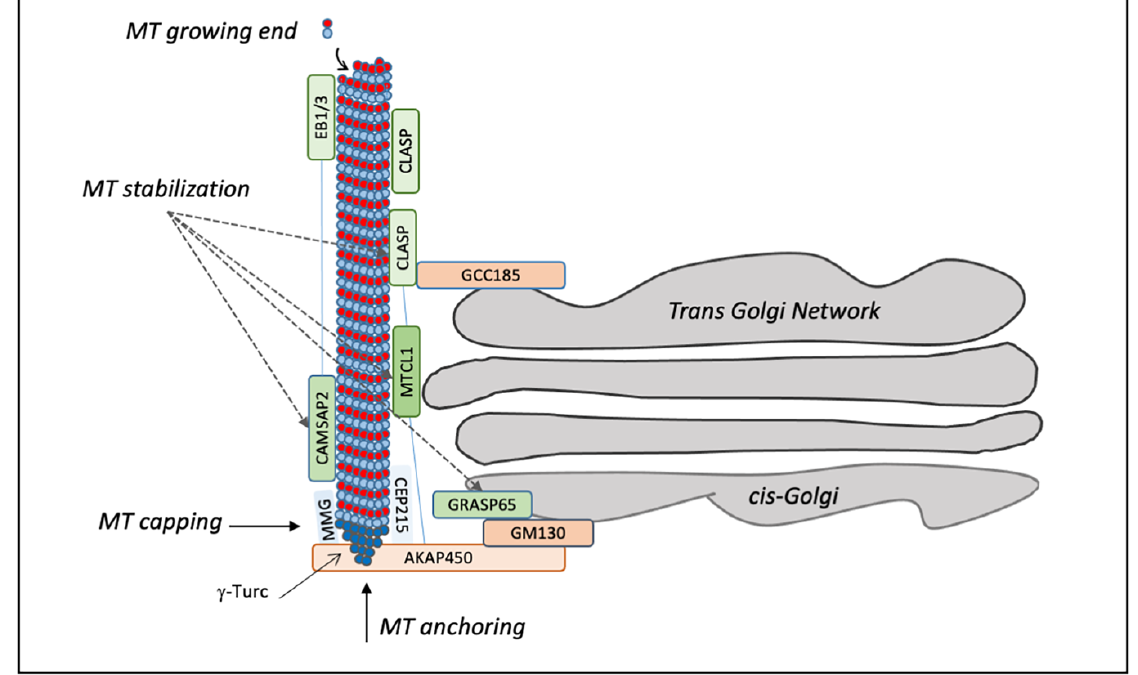
Figure 1. Schematic representation of microtubule polymerization at the Golgi. Microtubule fibres are polymerized starting from the γ -TuRC complex, which is responsible for capping the minus- end microtubules, while microtubules grow in the plus direction. GM130 at the cis -Golgi binds AKAP450, which in turn links CEP215 and MMG to recruit γ -TuRC for nucleation of Golgi-dependent microtubule. After their release from γ -TuRC, the microtubules are stabilized by CAMSAP2 and CLASP1/2, which are connected to the trans -Golgi through GCC185. The interaction between MTCL1 and CLASP1/2 can tether microtubules, whereas the length of the microtubules is regulated by CAMSAP2 when it associates with EBs proteins. The GM130 interactor GRASP65 regulates microtubule stabilization.